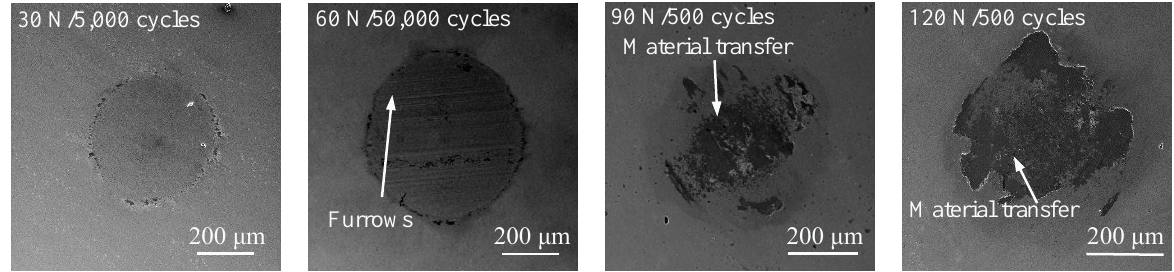
Figure 10. Wear scar of the counterbody against the CrN-coated HSS substrate under different con- dition.